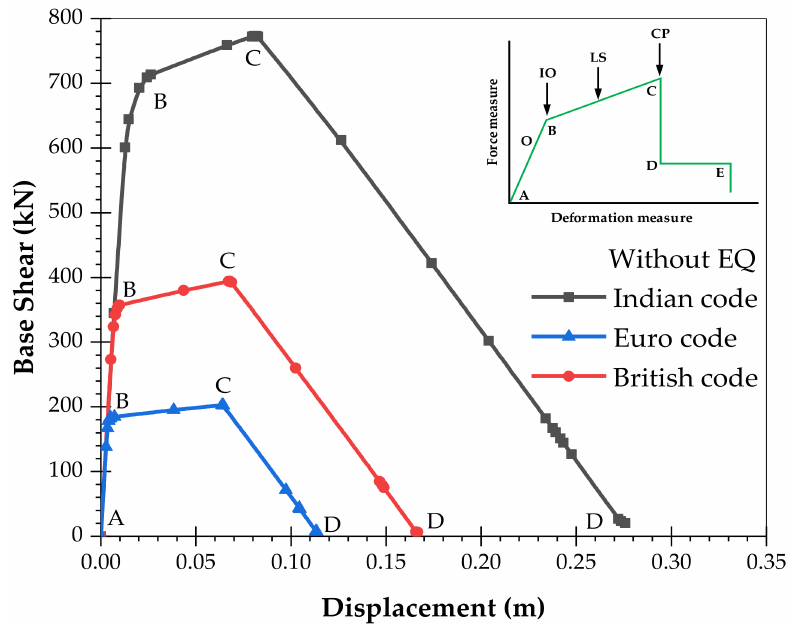
Figure 3. Pushover curve of models without earthquake